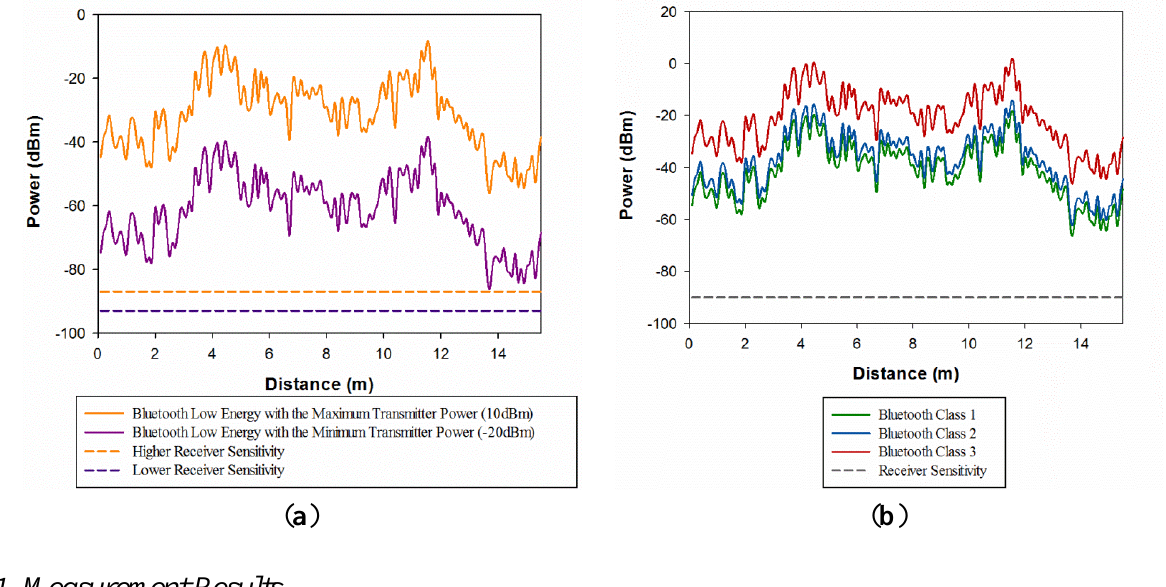
Figure 12. Estimation of radials of received power (dBm) along the X-axis for Y = 1.25 m and Z = 0.8 m along the indoor passenger wagon train ( a ) Comparison between the maximum and minimum transmitter power of Bluetooth Low Energy with the higher and lower receiver sensitivity ( b ) Comparison between classic Bluetooth and receiver sensitivity.